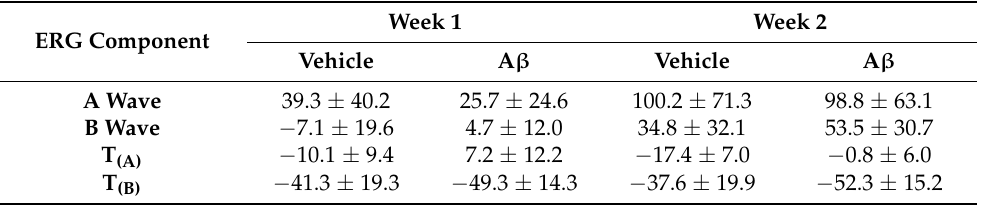
Table 3. Effects of subretinal A β on global retinal function assessed by scotopic full-field elec- troretinography. Retinal function was assessed 1 and 2 weeks post-injection with either A β 1-42 ( n = 7) or vehicle ( n = 6). Data shown as an average percentage change from baseline +/- the standard error of the mean (SEM) to account for intra-animal variability. Statistical significance was assessed p = 0.988), B-wave ( p = 0.534, p = 0.683), T (A) ( p = 0.445, p = 0.098) and T (B) ( p = 0.731, p =